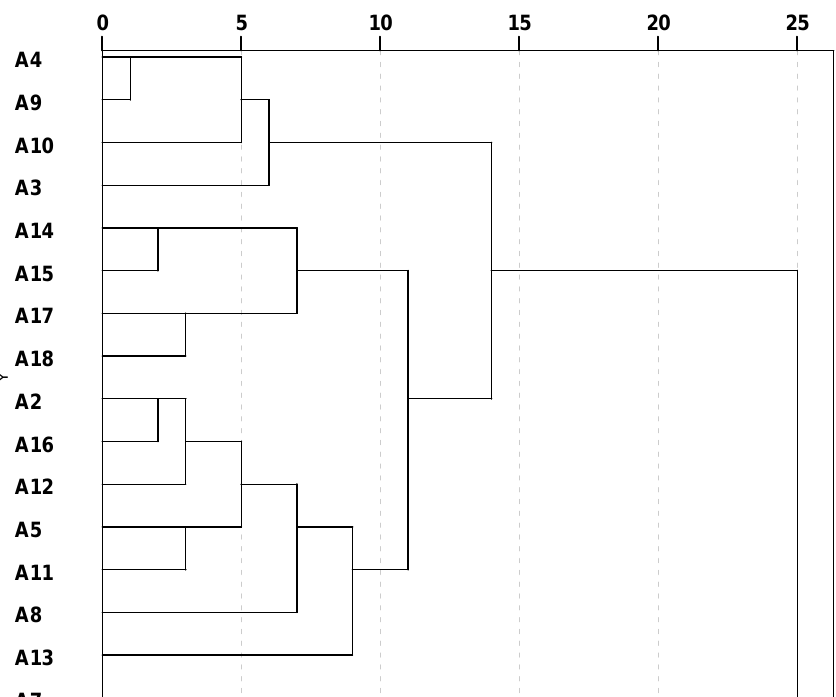
Figure 1. Dendrogram showing similarities between accessions of Conium roots according to the mean values of 10 analyzed compounds.